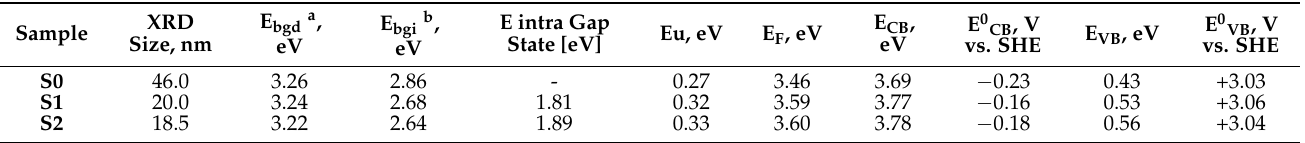
Table 4. Optical energies of the